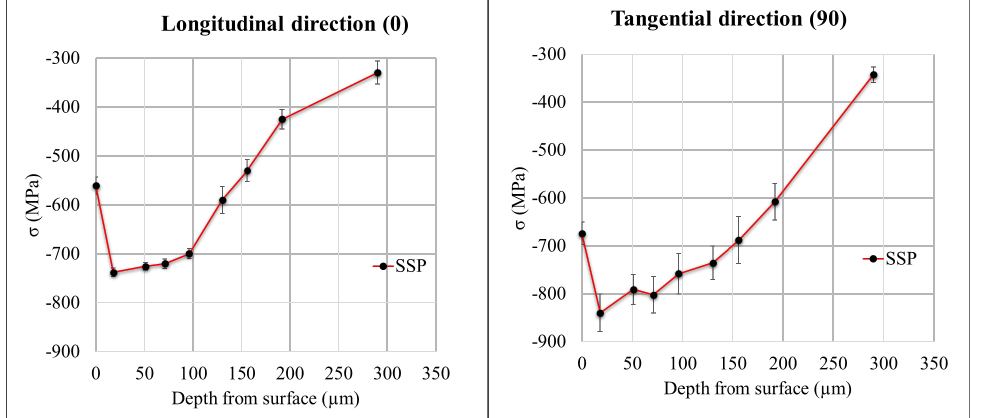
Figure 6. Residual stress depth profile for the severe shot peened sample